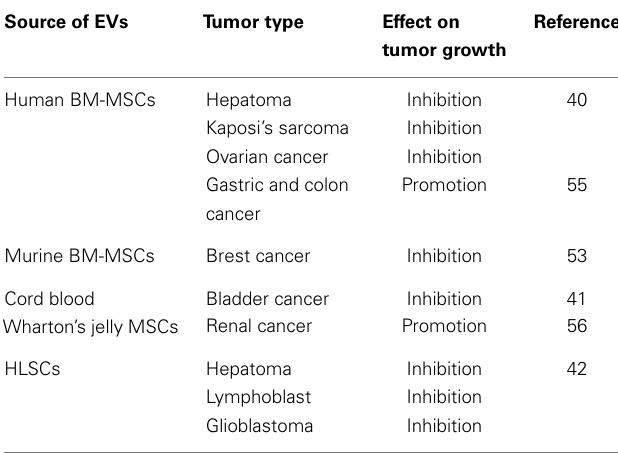
Table 1 | EVs from different MSC source have opposite effect on different tumor types